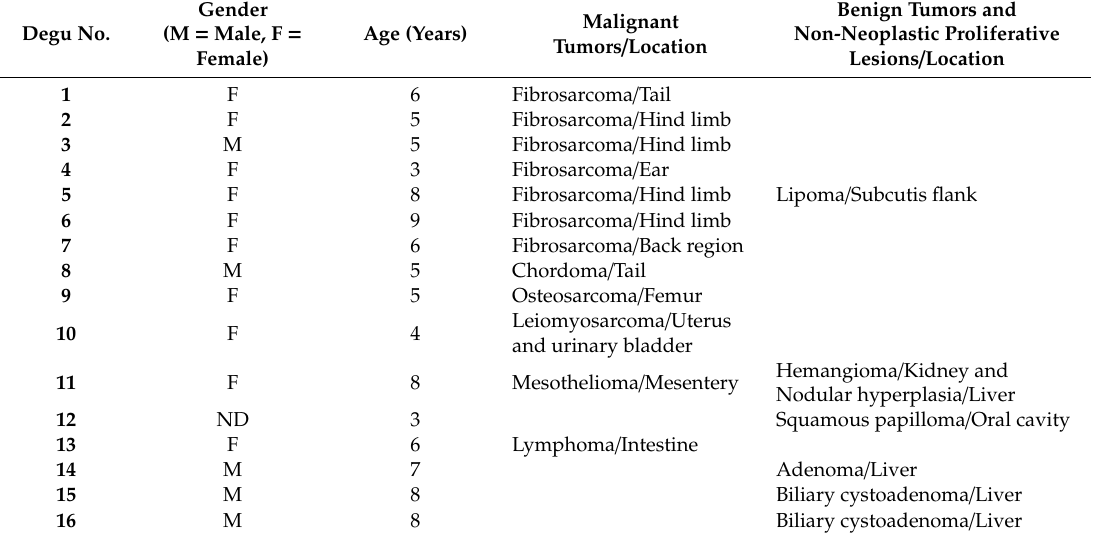
Table 1. Data about gender, age, diagnosis and location of tumors and non-neoplastic lesions observed in the 16 degus